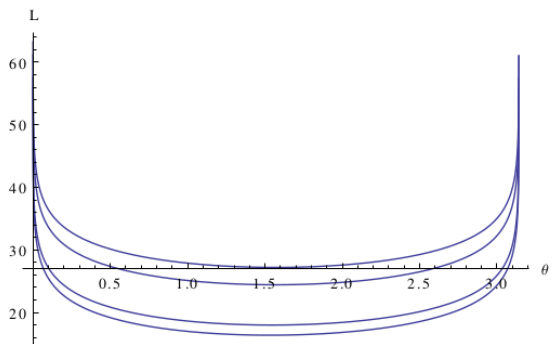
Figure 8 . L (cid:0) (cid:18) plot in the computation of (cid:1) W with di(cid:11)erent parameters. From top to bottom, the parameters of ( a; b; r ) are (10 ; 100 ; 0 : 05) ; (10 ; 100 ; 0 : 1) ; (10 ; 100 ; 0 : 5) ; (10 ; 100 ; 0 : 75). (cid:1) W (cid:3) 4 G N and the the optimal value of (cid:18) are (27 : 2046 ; (cid:18) ! 1 : 56818) (24 : 432 ; (cid:18) ! 1 : 5657) ; (17 : 9942 ; (cid:18) !